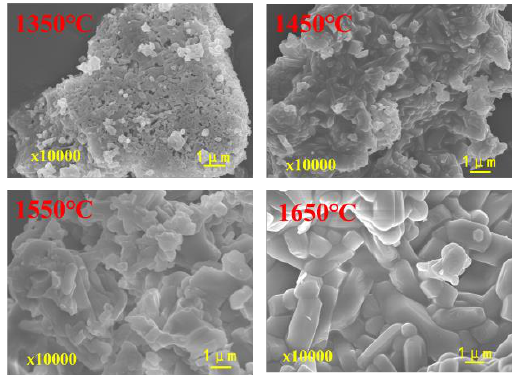
Figure 9. Morphology of the mullite under different calcination temperatures.